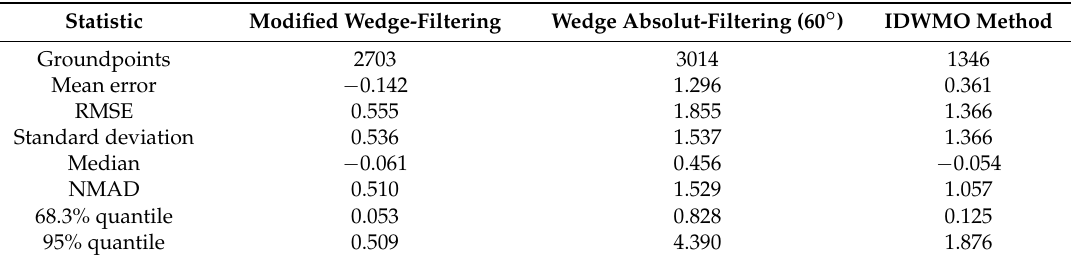
Table 2. Statistical values for the detail